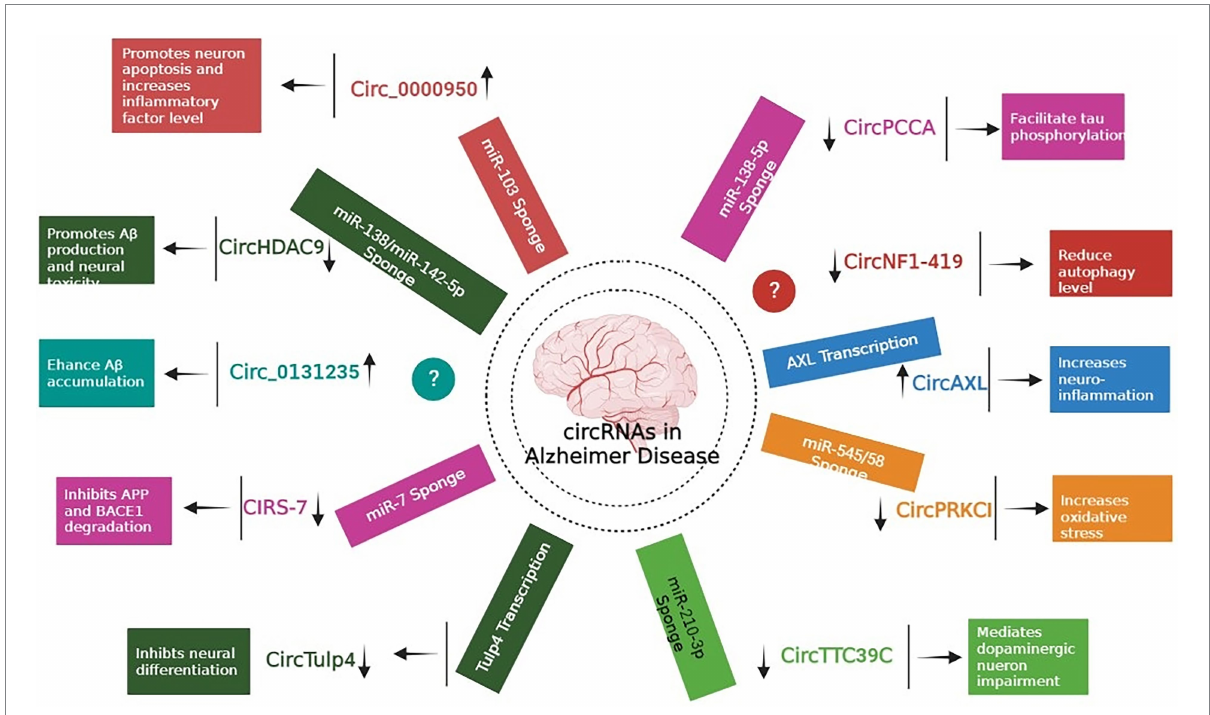
FIGURE 2 Role of different circRNAs in AD reported in both In-vitro and In-vivo models (Wang et al., 2015; Xie et al., 2016; Zhao et al., 2016; Ray et al., 2017; Shi et al., 2017; Zhang et al., 2018; Cheng et al., 2019; Diling et al., 2019; Lu et al., 2019; Yang H. et al., 2019; Li et al., 2020b; Bigarré et al., 2021; Ravanidis et al., 2021; Zhang and Bian,